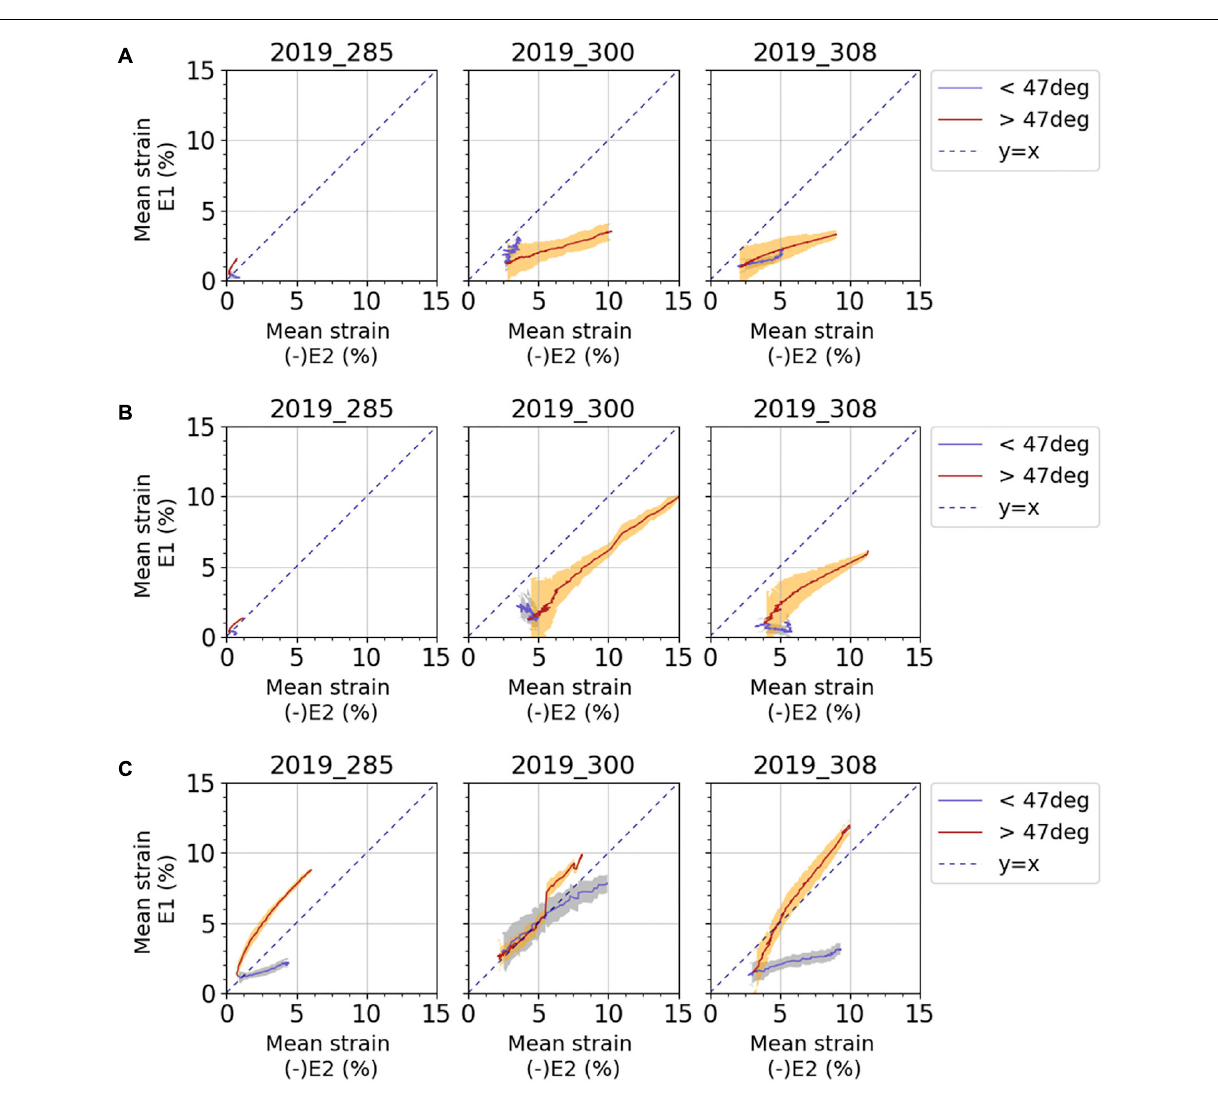
FIGURE 9 | Average curves for mean major principal strain E 1 against negative mean minor principal strain E 2 for (A) anterior fascia, (B) lateral fascia, and (C) ITT. Results are presented for each subject and for each test. Blue curves and light blue areas correspond respectively to average values and standard deviation obtained for a knee angle lower than the reference position of 47 ◦ : extended knee. Red curves and orange areas correspond respectively to average values and standard deviation obtained for a knee angle greater than the reference position of 47 ◦ : flexed knee. Dashed line represents the y = x curve; when points are along this line, pure shear can be